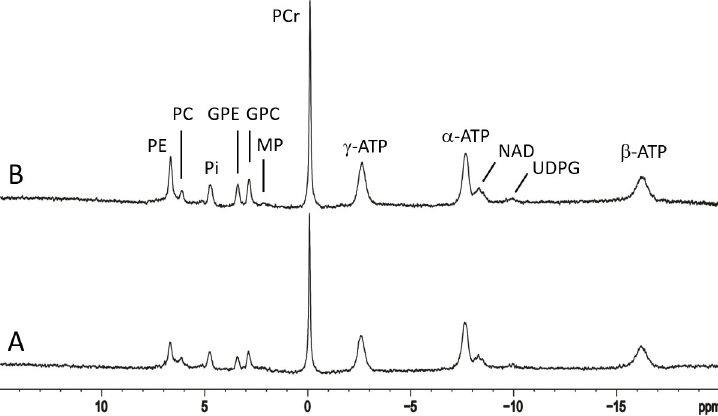
Fig 2. Typical 7 Tesla 31 P spectra of a healthy volunteer. A 7 Tesla spectrum at (A) TR = 3 seconds, NA = 64 and (B) TR = 30 s, NA = 32 x 2. PE: phosphoethanolamine; PC: phosphocholine; Pi: inorganic phosphate; GPE: glycerophosphoethanolamine; GPC: glycerophosphocholine; MP: membrane phospholipids; PCr: phosphocreatine; α -, β -, γ -ATP, α -, β -, γ -adenosine triphosphate; NAD: nicotinamide adenine dinucleotide; UDPG: uridine diphosphate